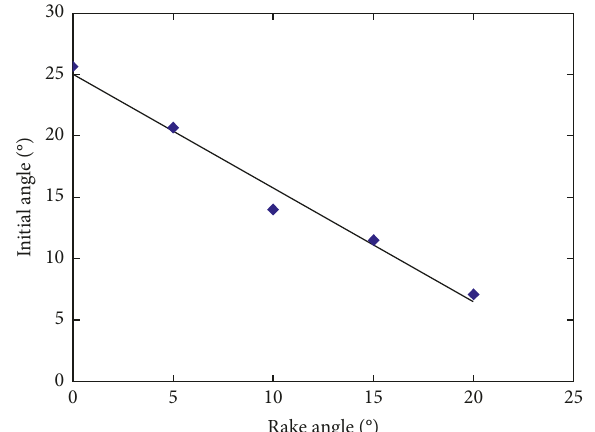
Figure 11: Initial angle of crack propagation at different indenter rake angles.